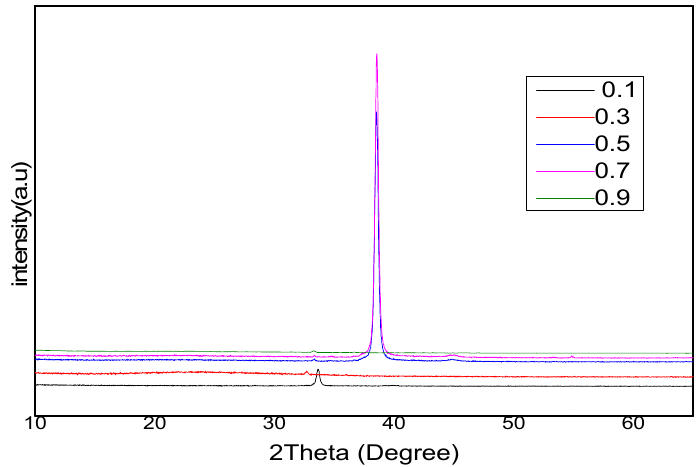
Figure 4. XRD patterns of In x Ga 1 − x N (x = 0.1, 0.3, 0.5, 0.7 and 0.9) thin films deposited on glass substrates using thermal vacuum evaporation (TVE).